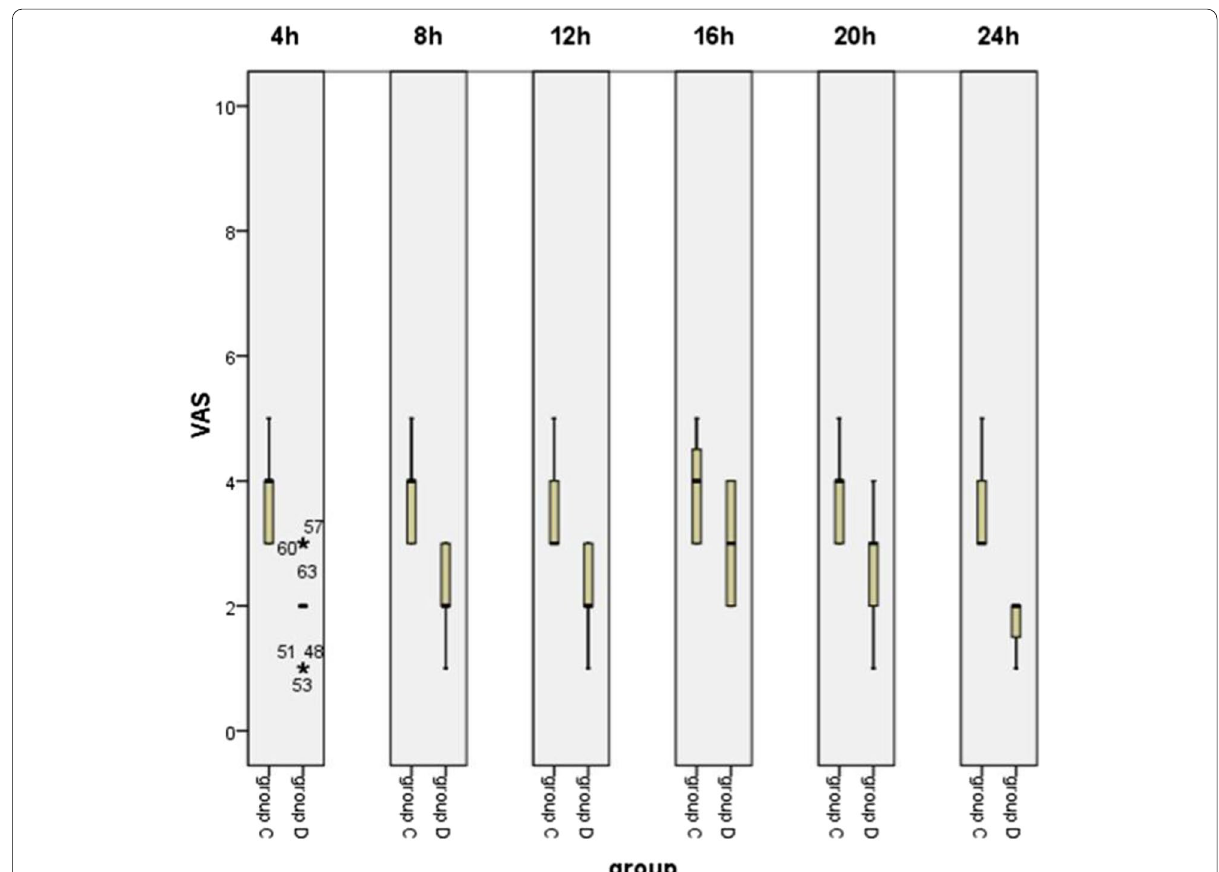
Fig. 2 Visual analog scale (VAS). The middle black solid line represents the median; the upper and lower margins of each box represent the IQR. Asterisk is maximum and minimum values; asterisk represents the number of patients with outlier